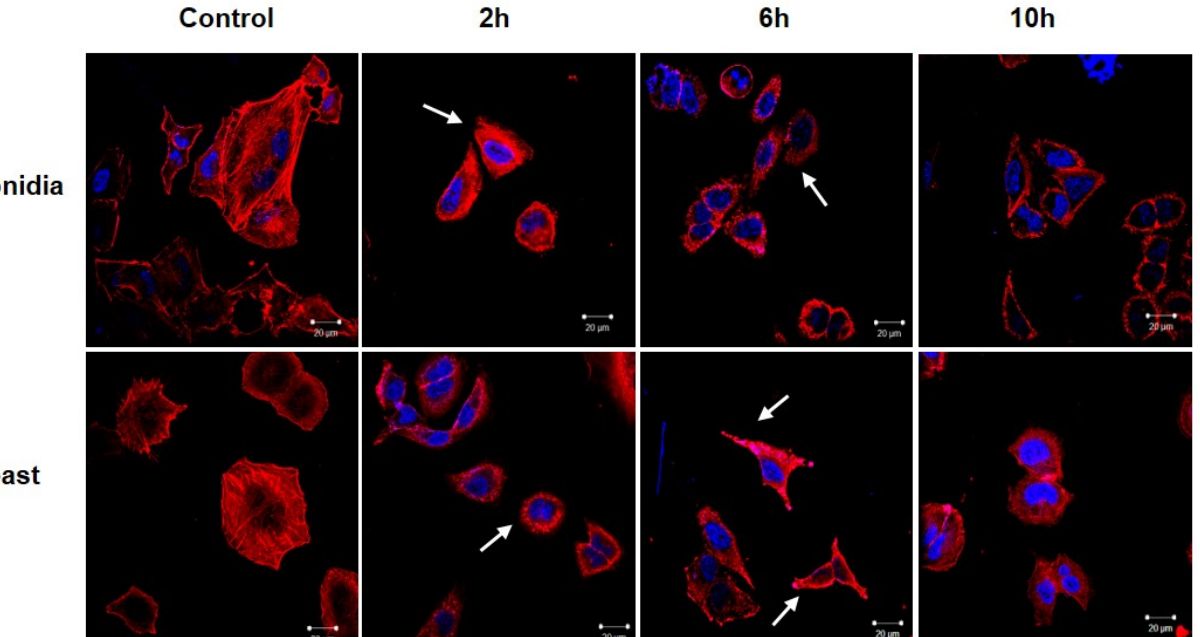
Figure 3. Formation of membrane protuberances and loss of stress fibers in keratinocytes infected with conidia and yeast cells of Sporothrix schenckii . Infection with conidia and yeast cells of Sporothrix schenckii at 6 h post-infection at a 1:1 MOI. The actin filaments were stained with rhodamine phalloidin (red), and the cell nuclei with DAPI (blue). Digitally amplified images.